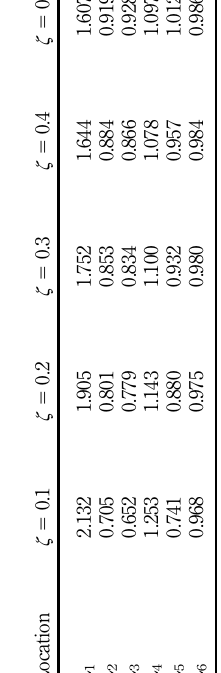
Table 7. Sensitivity